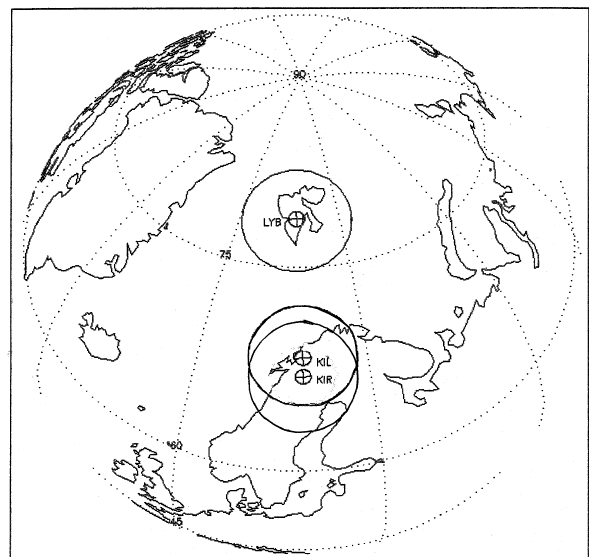
Fig. 1. Location of the three FPIs at Longyearbyen, Kilpisjarvi and Kiruna. The circles surrounding each site indicate the field of view of the FPI for the zenith angle of observation used with each FPI. This assumes a peak emission height of 240 km for the 630 nm emission and a zenith angle of 60 ◦ which gives a circle with radius 416 km.